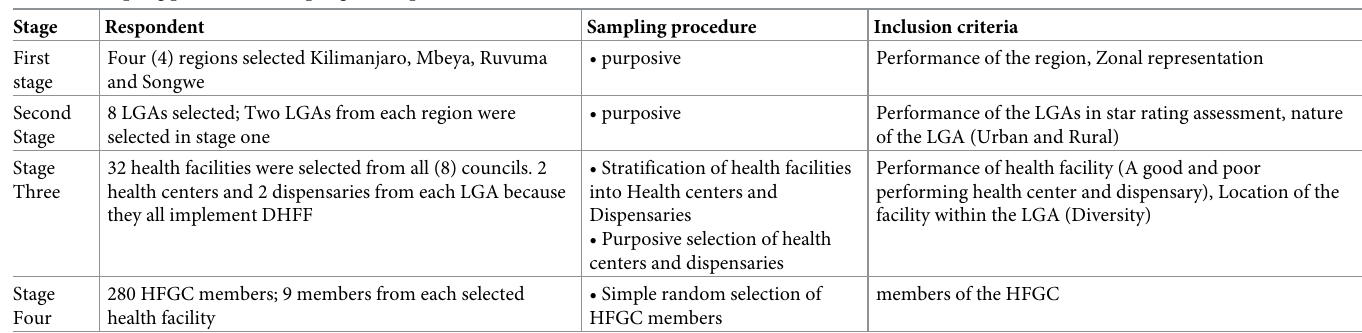
Table 1. Sampling process and sampling